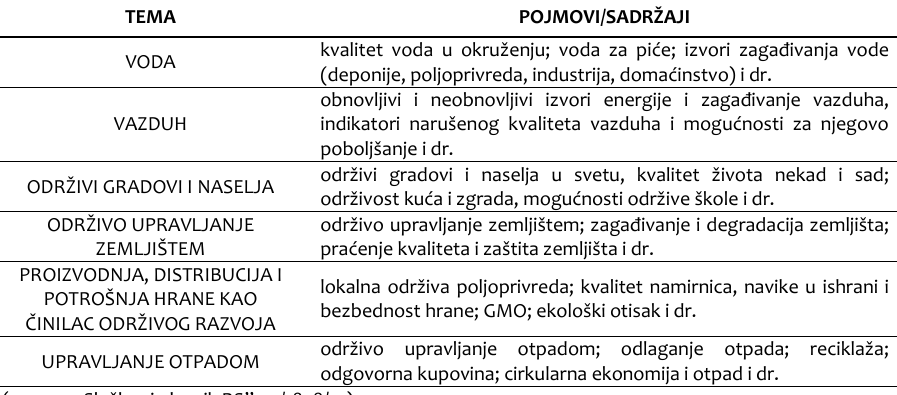
okviru izbornog programa Obrazovanje za održivi razvoj u prvom i drugom razredu gimnazije. Tabela 1. Izborni program Obrazovanje za održivi razvoj: pregled tema, pojmova i